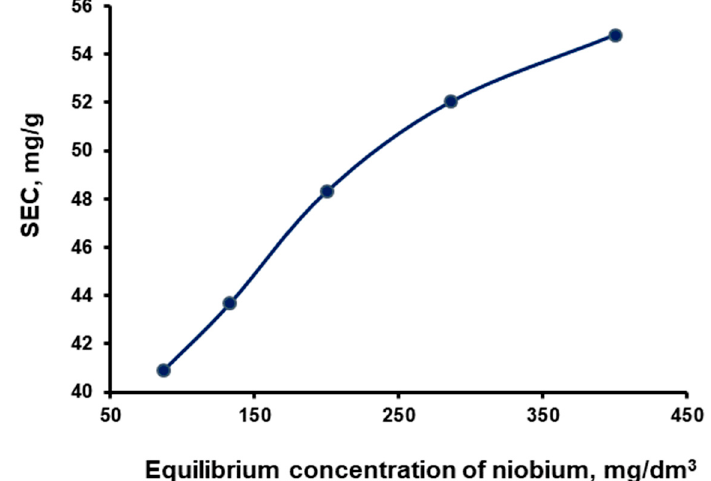
Figure 2. Dependence of Purolite A-100 ion-exchange resin on equilibrium concentration of nio- bium.